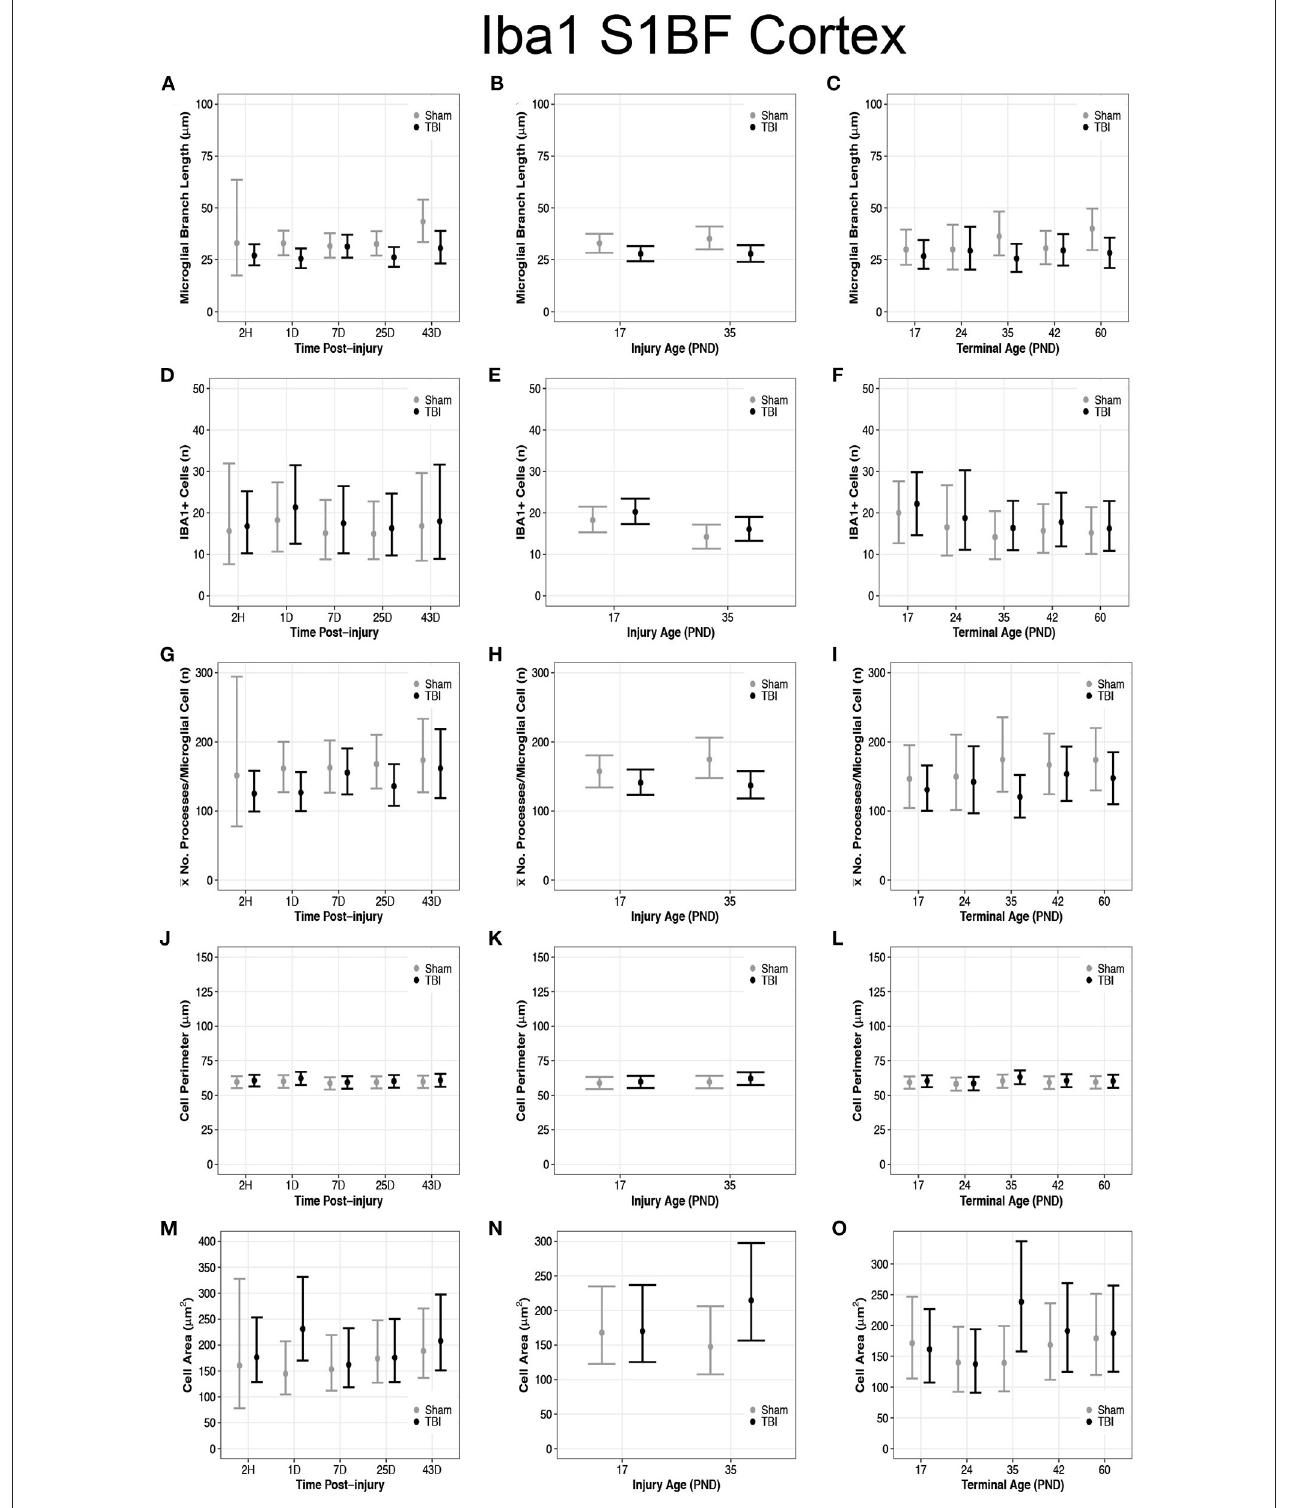
FIGURE 4 | Diffuse TBI activated microglia in the S1BF of rats injured at PND17 and PND35. Point estimates (posterior means) and corresponding 95% credible intervals (highest posterior density intervals) are presented. (A) TBI rats at 1D, 25D, and 43D post-injury had shorter microglial branch lengths than shams. (B) TBI